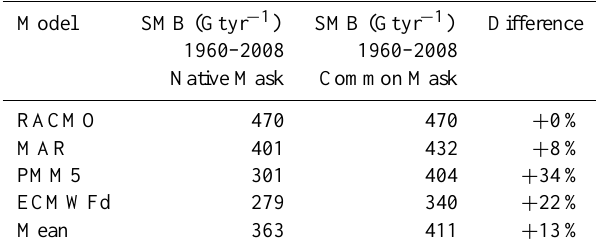
Table 2. Average annual SMB on model’s native mask and the com- mon mask.